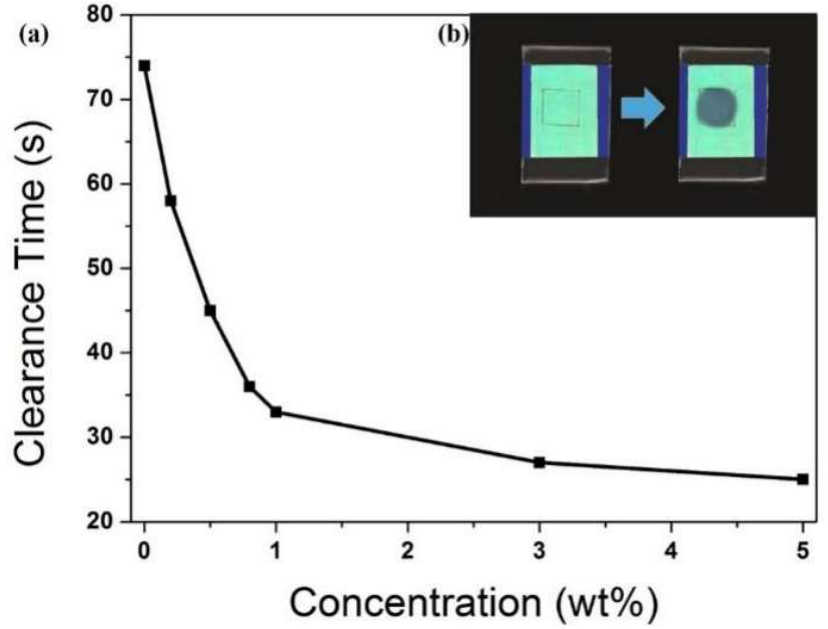
Figure 4. ( a ) The clearance time of different LC samples in the thermal erasing experiment. ( b ) The photographs of sample 7 before and after the thermal erasing experiment.